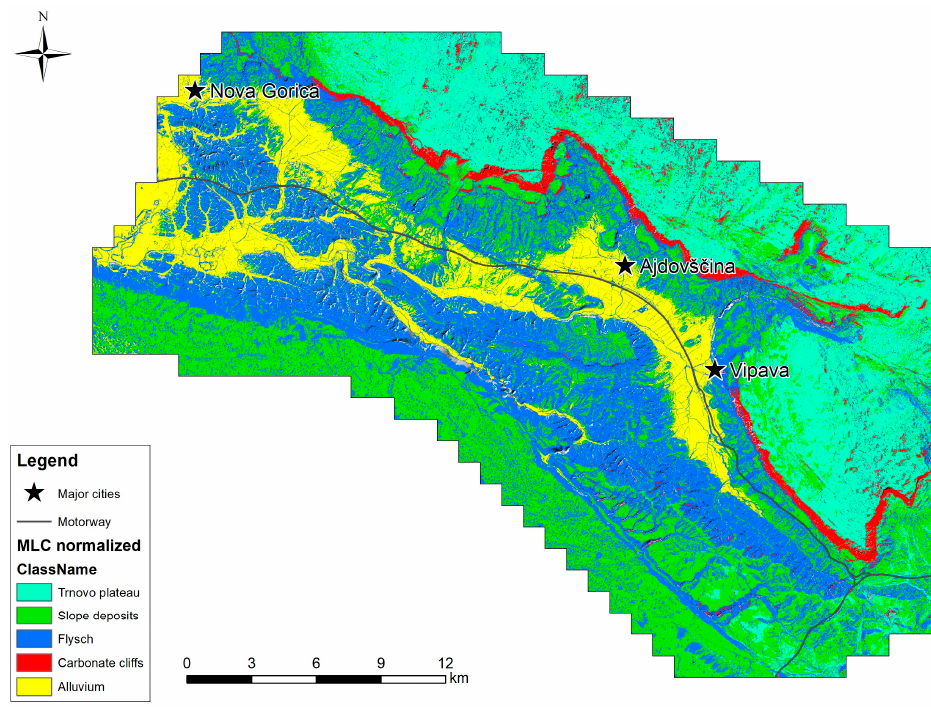
Figure 3. General map of the MLC prediction.